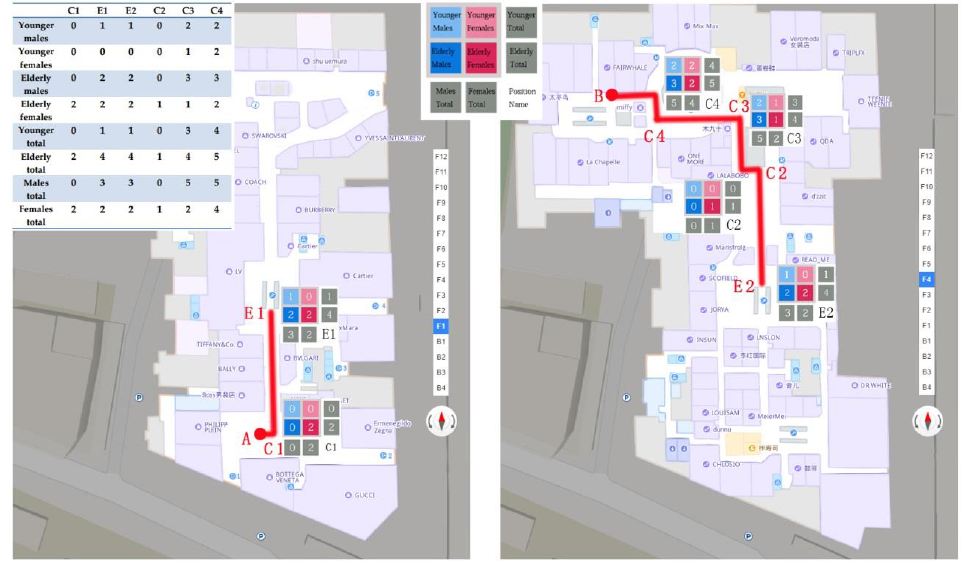
Figure 10. Error counts made by different groups (younger male, younger female, elderly male, and elderly female) at turning positions and elevator.